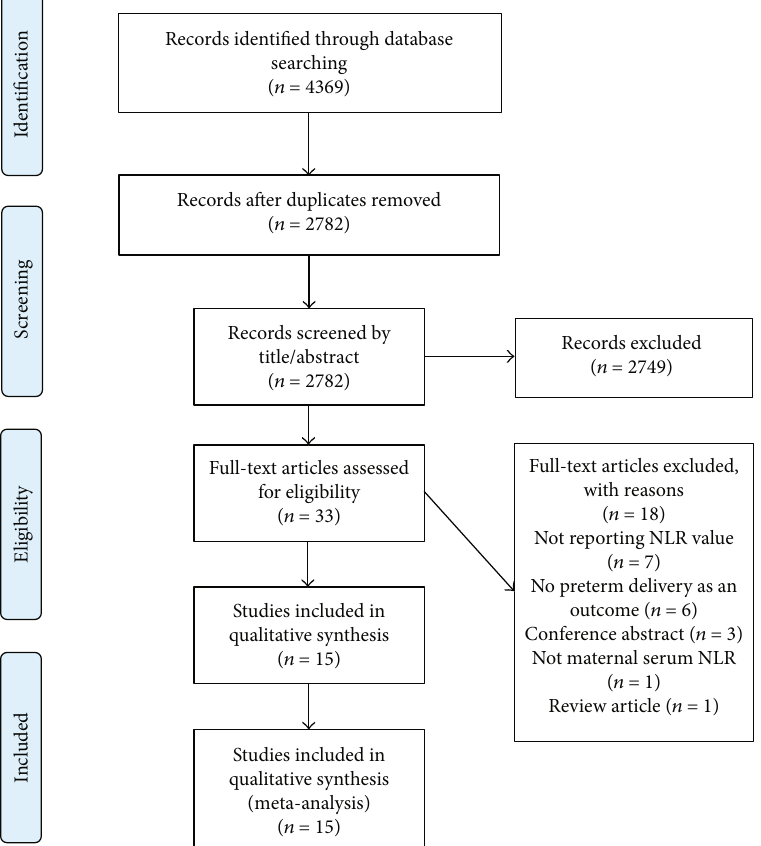
Figure 1: The fl owchart of literature search and study identi fi